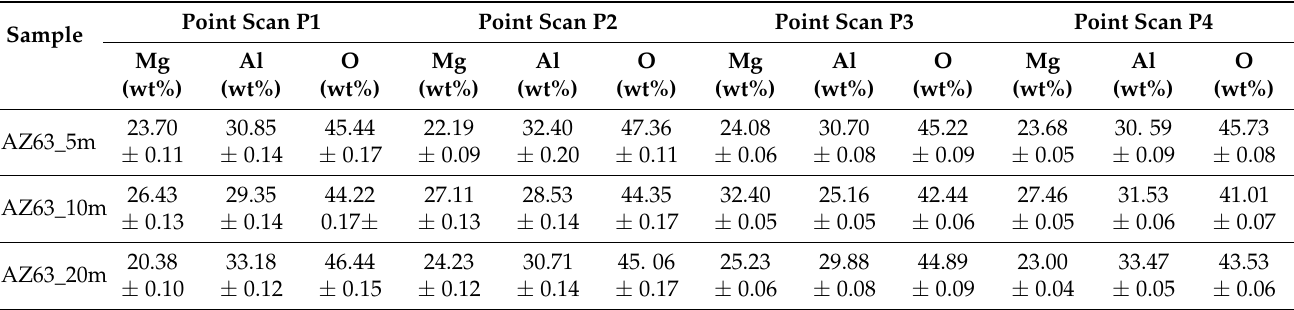
Table 4. Chemical composition of the selected representative PEO coatings’ surfaces.